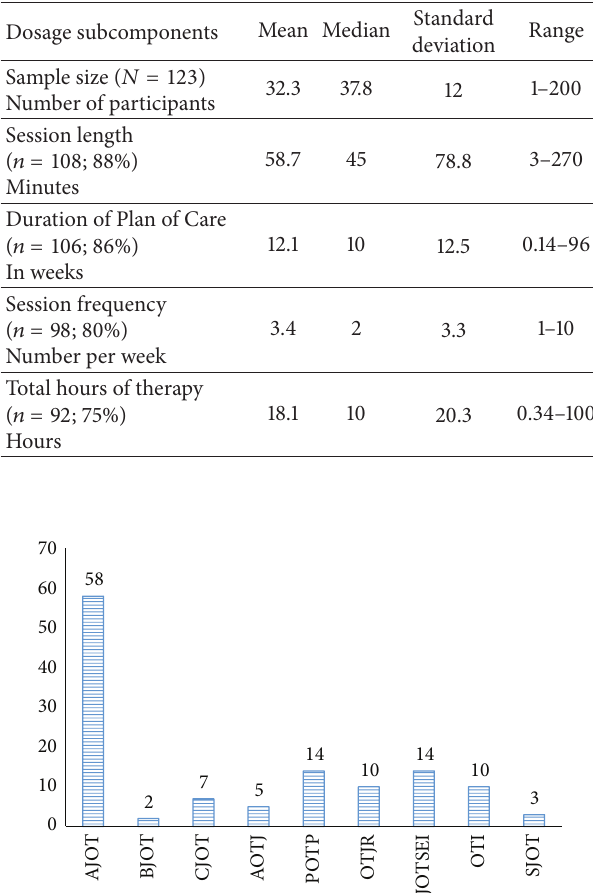
Figure 1: Frequency of articles from the journals reviewed.